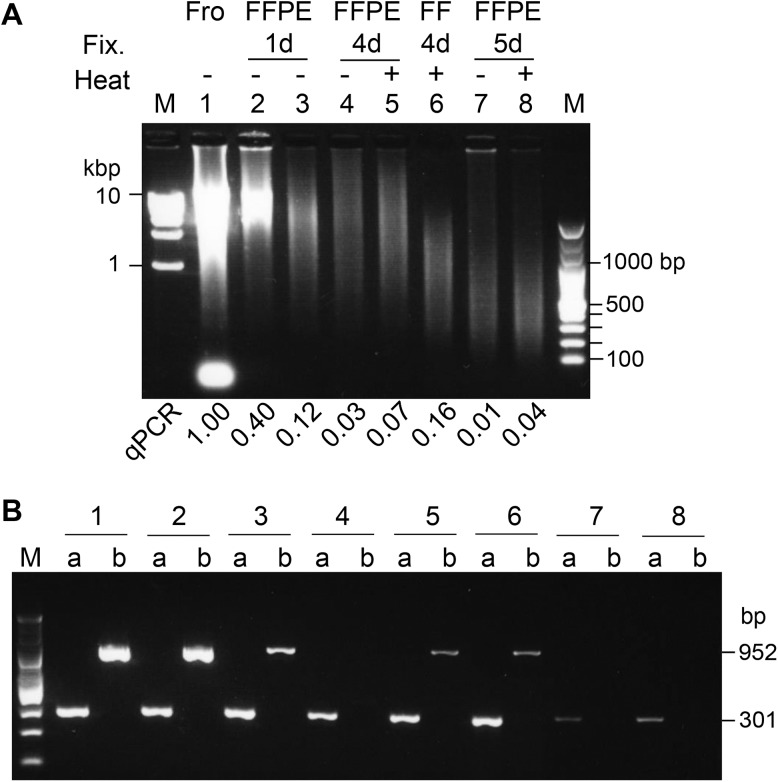
Agarose gel electrophoresis of rat liver DNA.(A) Agarose gel electrophoresis (0.8%) of 400 ng of purified DNA. DNA on the gel were stained with GelRed which is sensitive to double-stranded DNA. The qPCR ratio to matched frozen tissue DNA is shown at the bottom of each lane. Fro, frozen tissue DNA; Fix., fixation for 1 day (1 d): lanes 2 and 3 were different tissue samples with 1 day fixation, 4 days (4 d) and 5 days (5 d); Heat, heat treatment of lysate (+) or not (-) at 95°C for 30 minutes; M, molecular weight marker; qPCR, qPCR ratio to frozen tissue DNA. (B) Agarose gel electrophoresis (2%) of PCR products with target sizes of 301 bp (a) and 952 bp (b). The rat Tp53 gene was amplified from the indicated DNA, lanes 1 to 8 in (A).